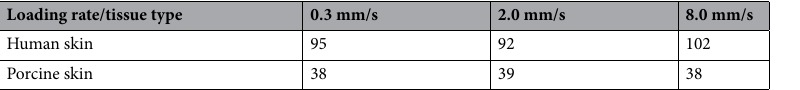
Table 1. The number of samples of full thickness burned human and porcine skin tissues for three loading rates after removing the outliers.